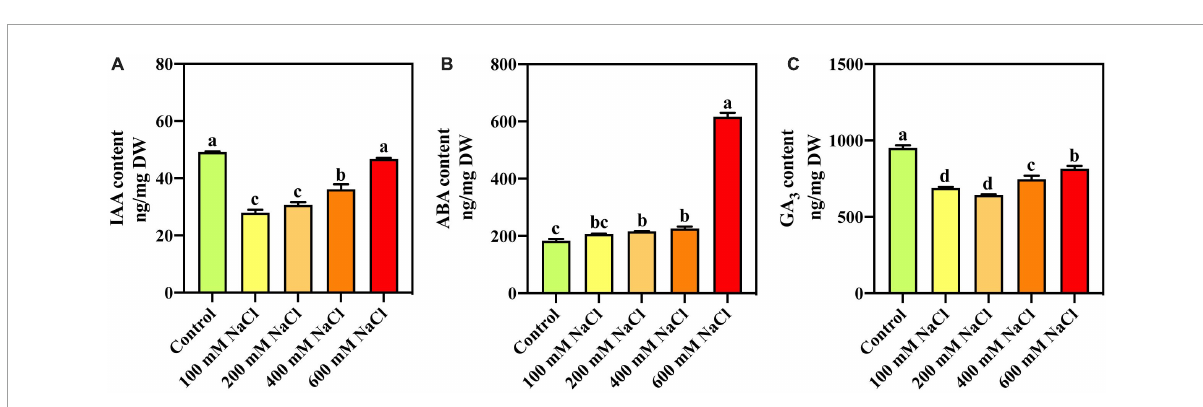
FIGURE2 The content of IAA (A) , ABA (B) , and GA 3 (C) in the leaves of S. portulacastrum under salt